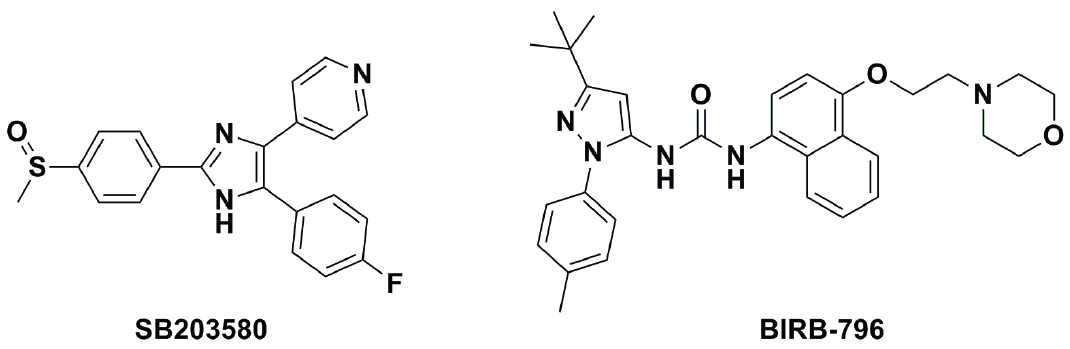
Figure 2. Chemical structures of SB-203580 and